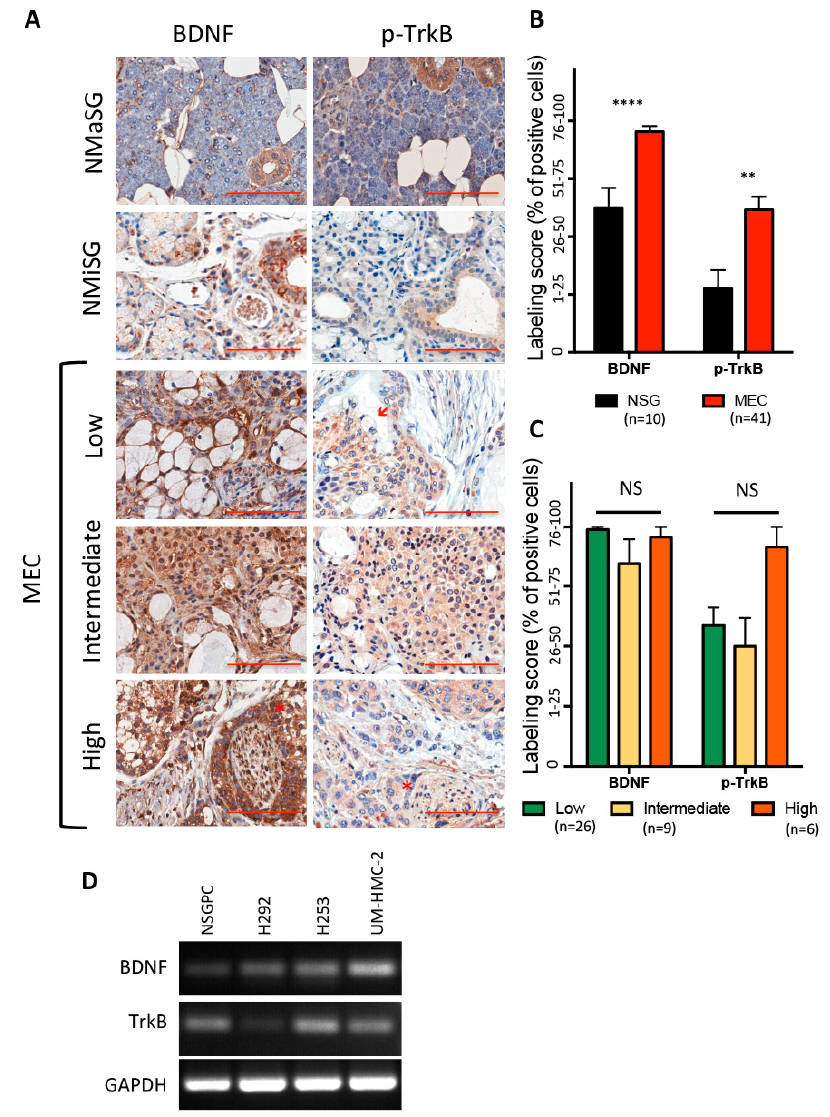
Figure 1. ( A ) Representative images of BDNF and pTrkB immunostaining in normal minor (MiSG) and major salivary glands (MaSG) and mucoepidermoid carcinoma (MEC) with different grades. Note the absence of pTrkB expression in mucous cells (arrow) and the presence of expression in cells associated with perineural invasion (asterisk). ( B ) The percentage of BDNF- and pTrkB-positive cells was significantly higher in MEC, compared to normal salivary gland tissue (scores obtained from the joint analysis of MaSG and MiSG) ( p < 0.0001 and p = 0.0075, respectively, Mann-Whitney Test). ( C ) No significant difference was detected among the different MEC grades concerning BDNF and pTrkB expression ( p > 0.05, Kruskal-Wallis Test), however, high-grade tumours presented a tendency for elevated percentage of pTrkB positive cells. ( D ) BDNF and pTrkB transcript levels in normal salivary gland primary cells (NSGPC) and MEC cell lines revealed higher BDNF expression in all MEC cell lines compared to NSGPC. Interestingly, high TrkB expression was observed in the high-grade salivary gland MEC (H253) with lower expression in the pulmonary MEC cell line (H292). The levels of UM-HMC-2 were similar to NSGPC (** p < 0.01; **** p < 0.0001, and NS p >